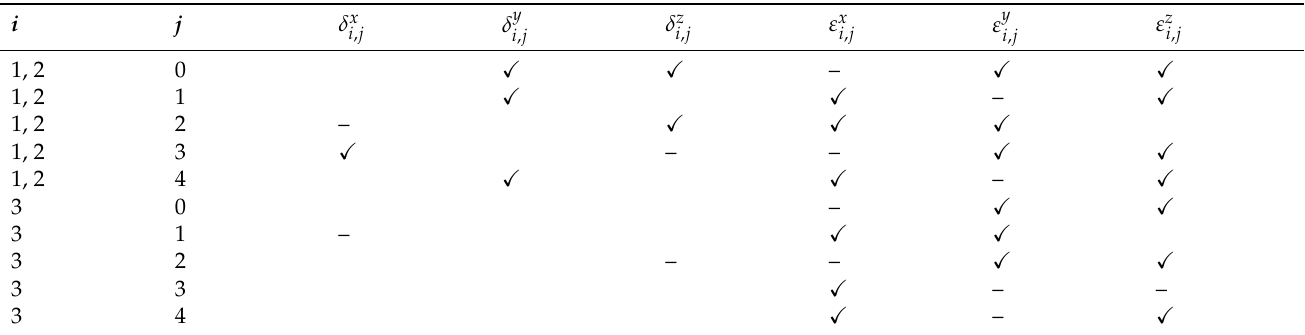
Table 7. Identified internal-force-and-deformation-related geometric errors.